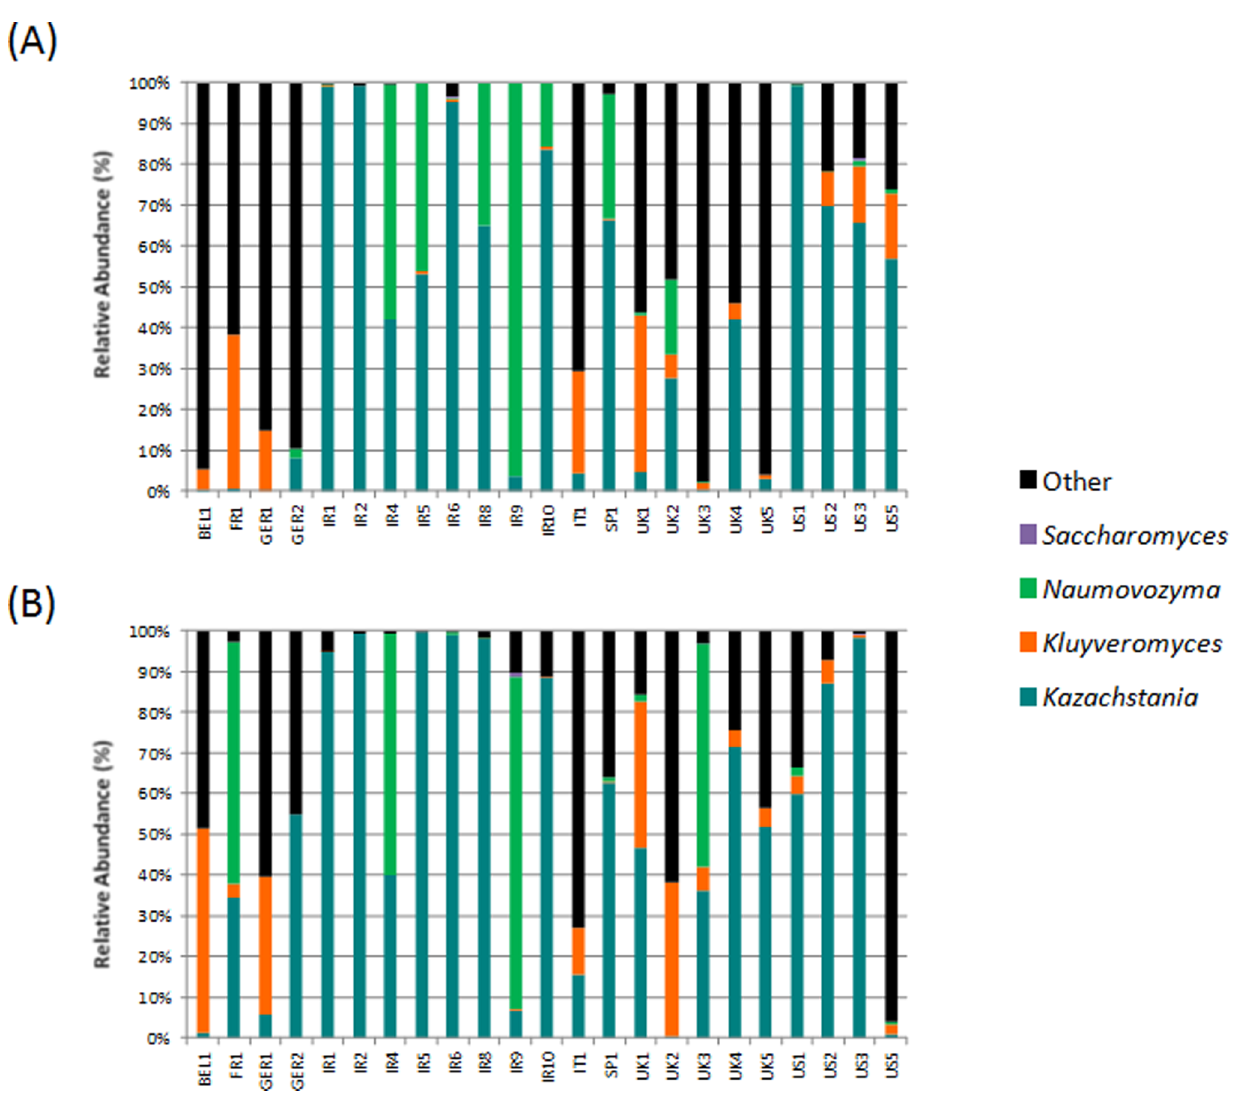
Figure 4. ITS phylogenetic composition of the fungal component of the kefir grain (A) and kefir fermented milk (B) at genus level.